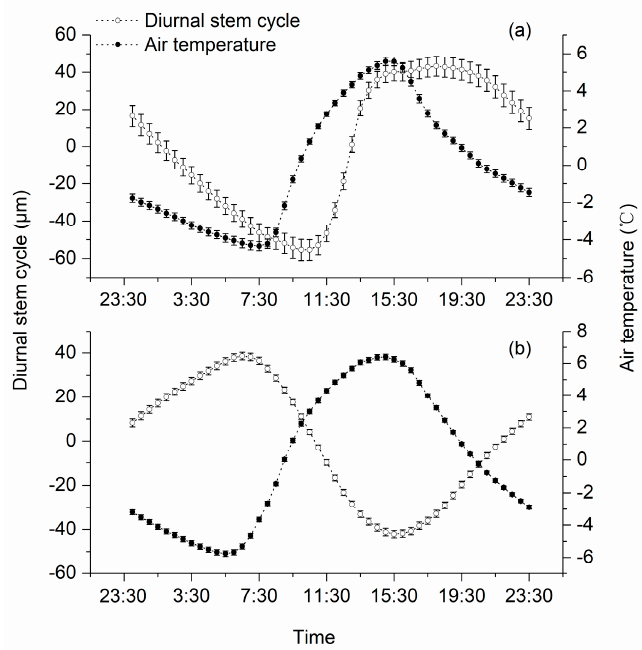
Figure 4. Mean diurnal cycles of stem radius and air temperature changes over stages ( a ) 1 and ( b ) 2. Error bars indicate standard Error bars indicate standard error.